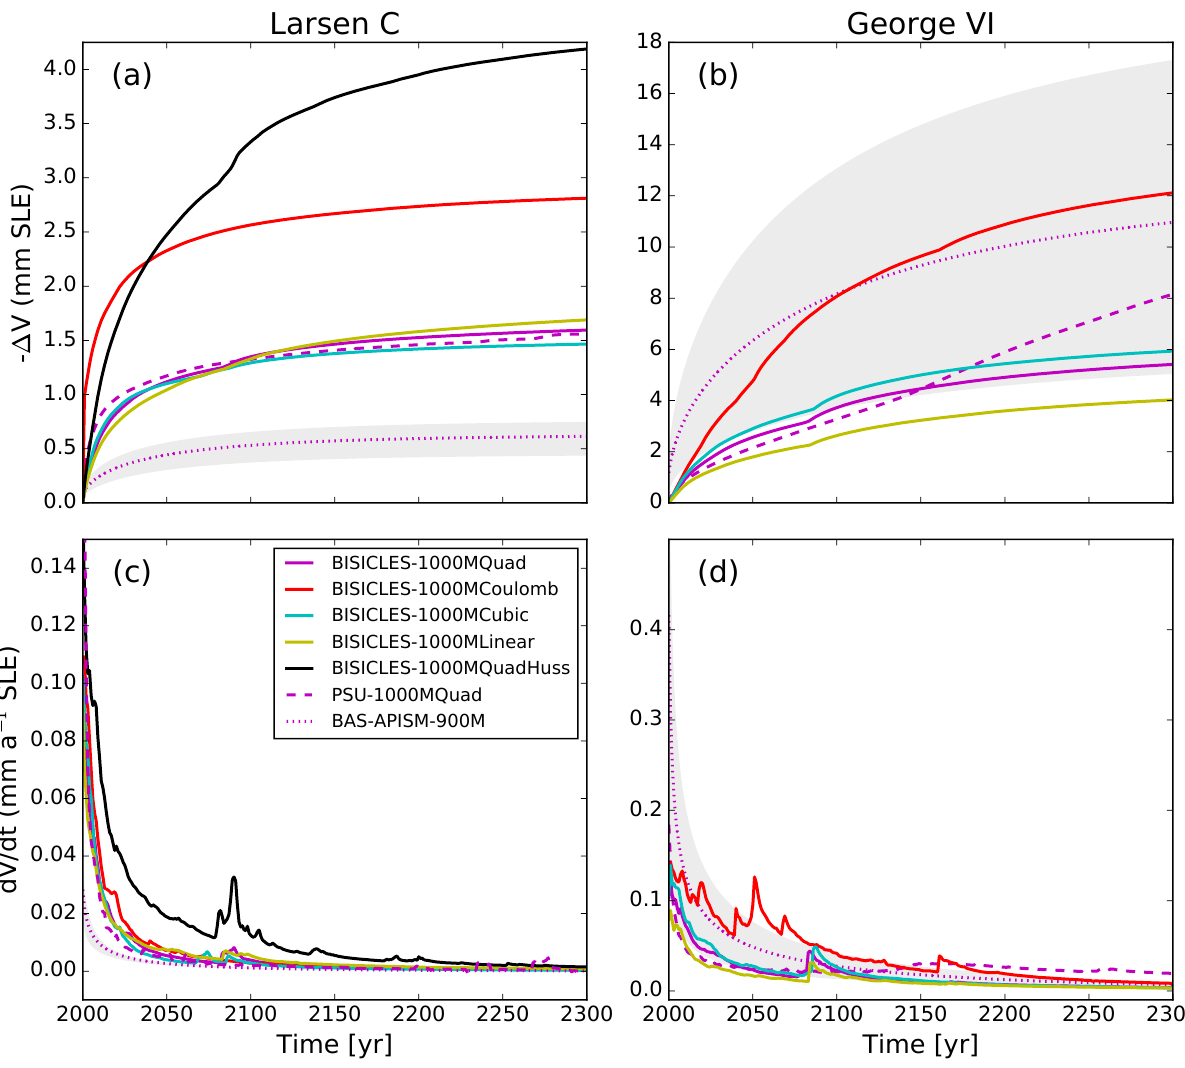
Figure 4. Upper panels (a, b) show SLR projections from Experiment 1 (immediate shelf collapse) for BISICLES (solid lines), PSU3D (dashed lines), and BAS-APISM (dotted line). Lower panels (c, d) show the derivative (rate of change) of the corresponding SLR projections in the upper panels (a, b) . Grey shading displays uncertainty associated with SLR projections from BAS-APISM. Uncertainties are quantified by a Monte Carlo simulation (see Schannwell et al., 2016). Note the different y axis scales. Projections with the Huss and Farinotti (2014) data set are only available for Larsen C. Quad is